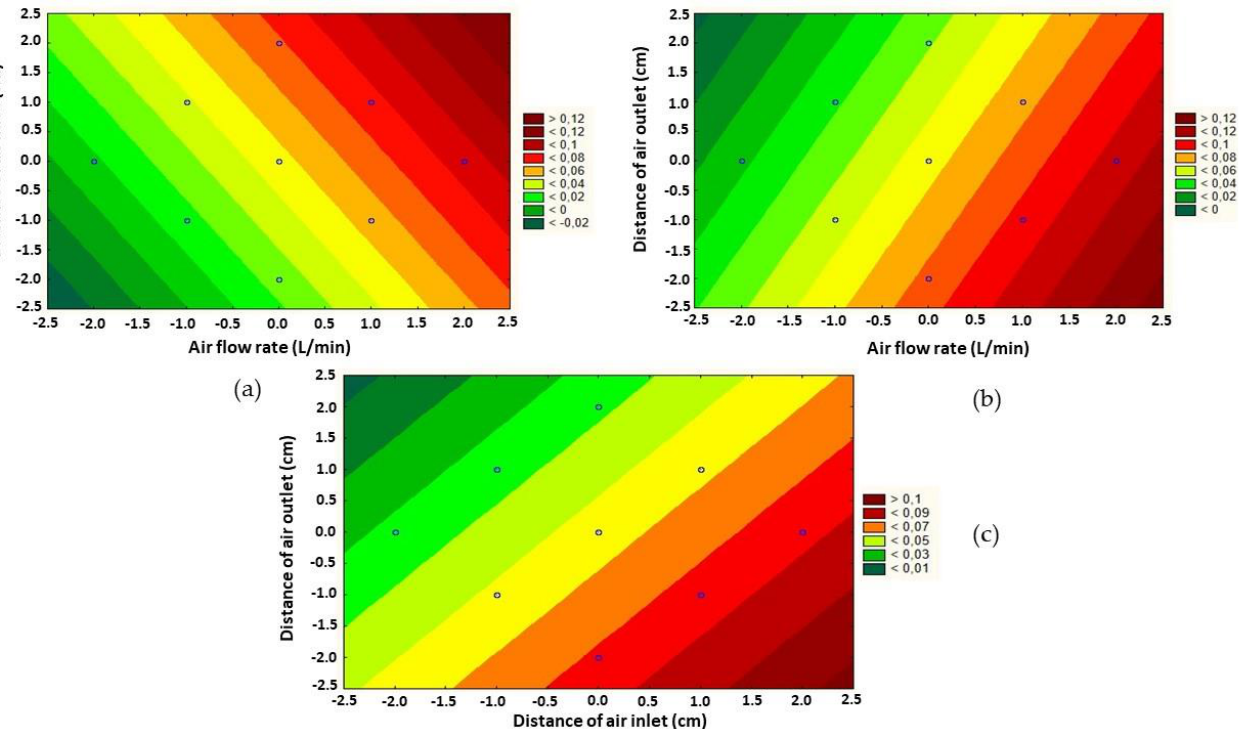
Figure 18. 2D contour graph of the interaction effects for the lateral air inlet and outlet geometry. Simultaneous effects on velocity exerted by ( a ) distance of air inlet and air flow rate; ( b ) distance of air outlet and air flow rate; ( c ) distance of air inlet and distance of air outlet.